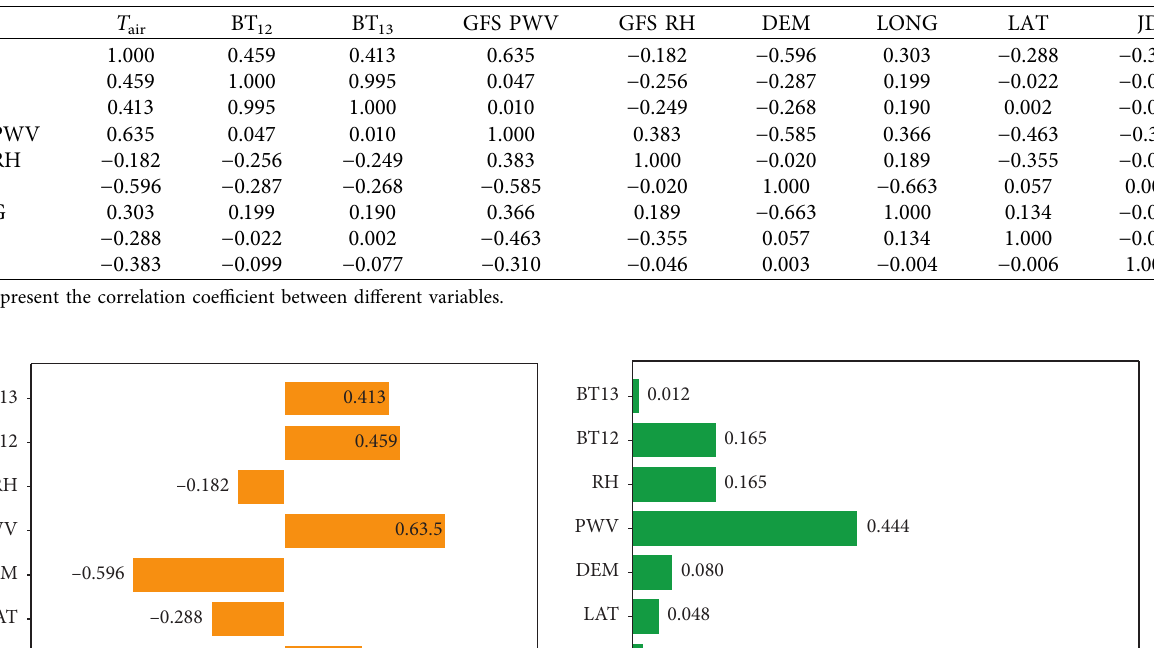
Table 2: Pearson correlation matrix for variables considered in the T